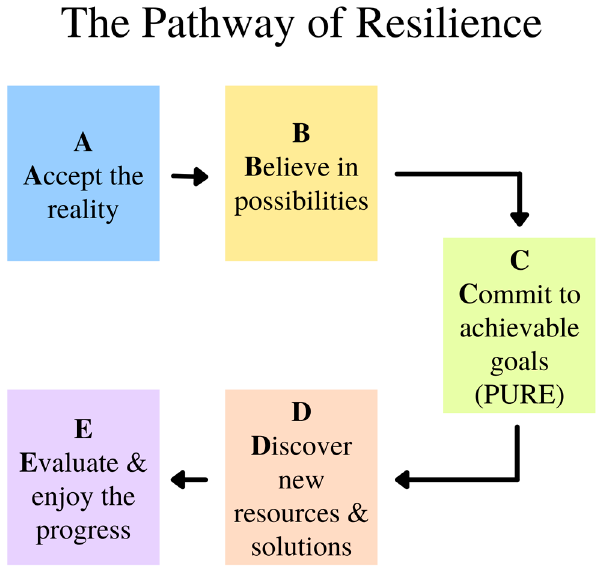
Figure 7. The Pathway of Resilience.